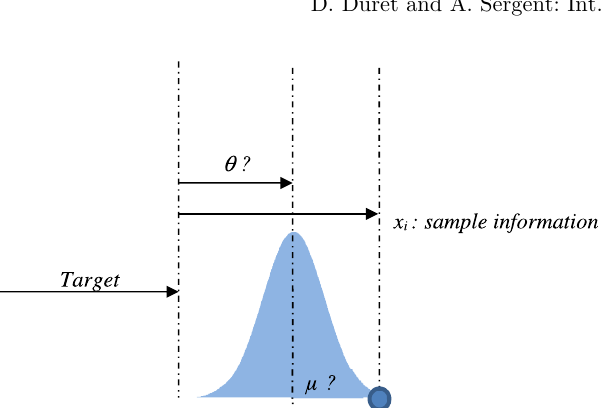
Fig. 1. Example of graphical presentation of the law of the variable